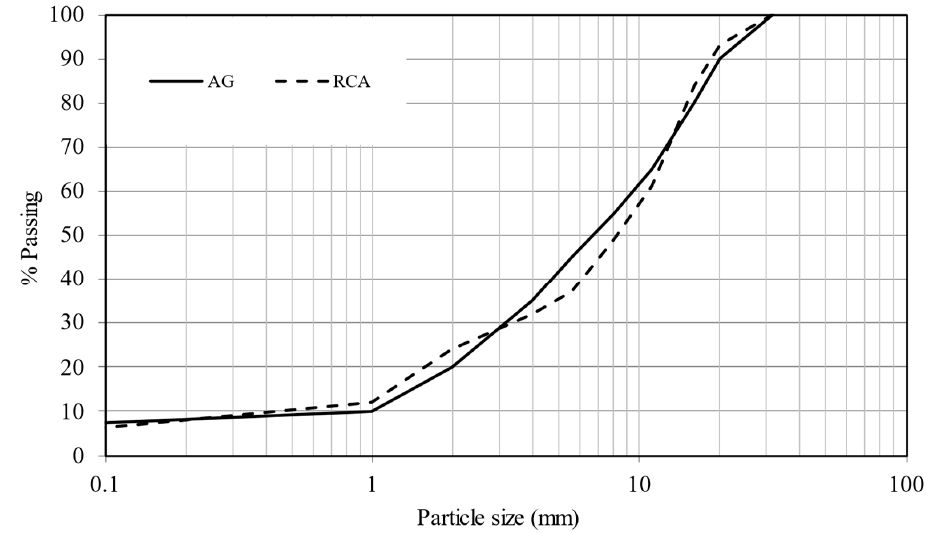
Figure 3. Particle size distribution curves limits of artificial gravel (AG) and recycled concrete aggregates (RCA).